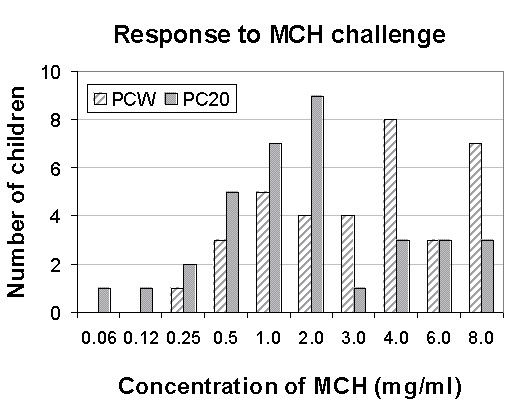
Number of children responding to each MCH concentration (mg/ml) at PCW and at PC20-FEV1